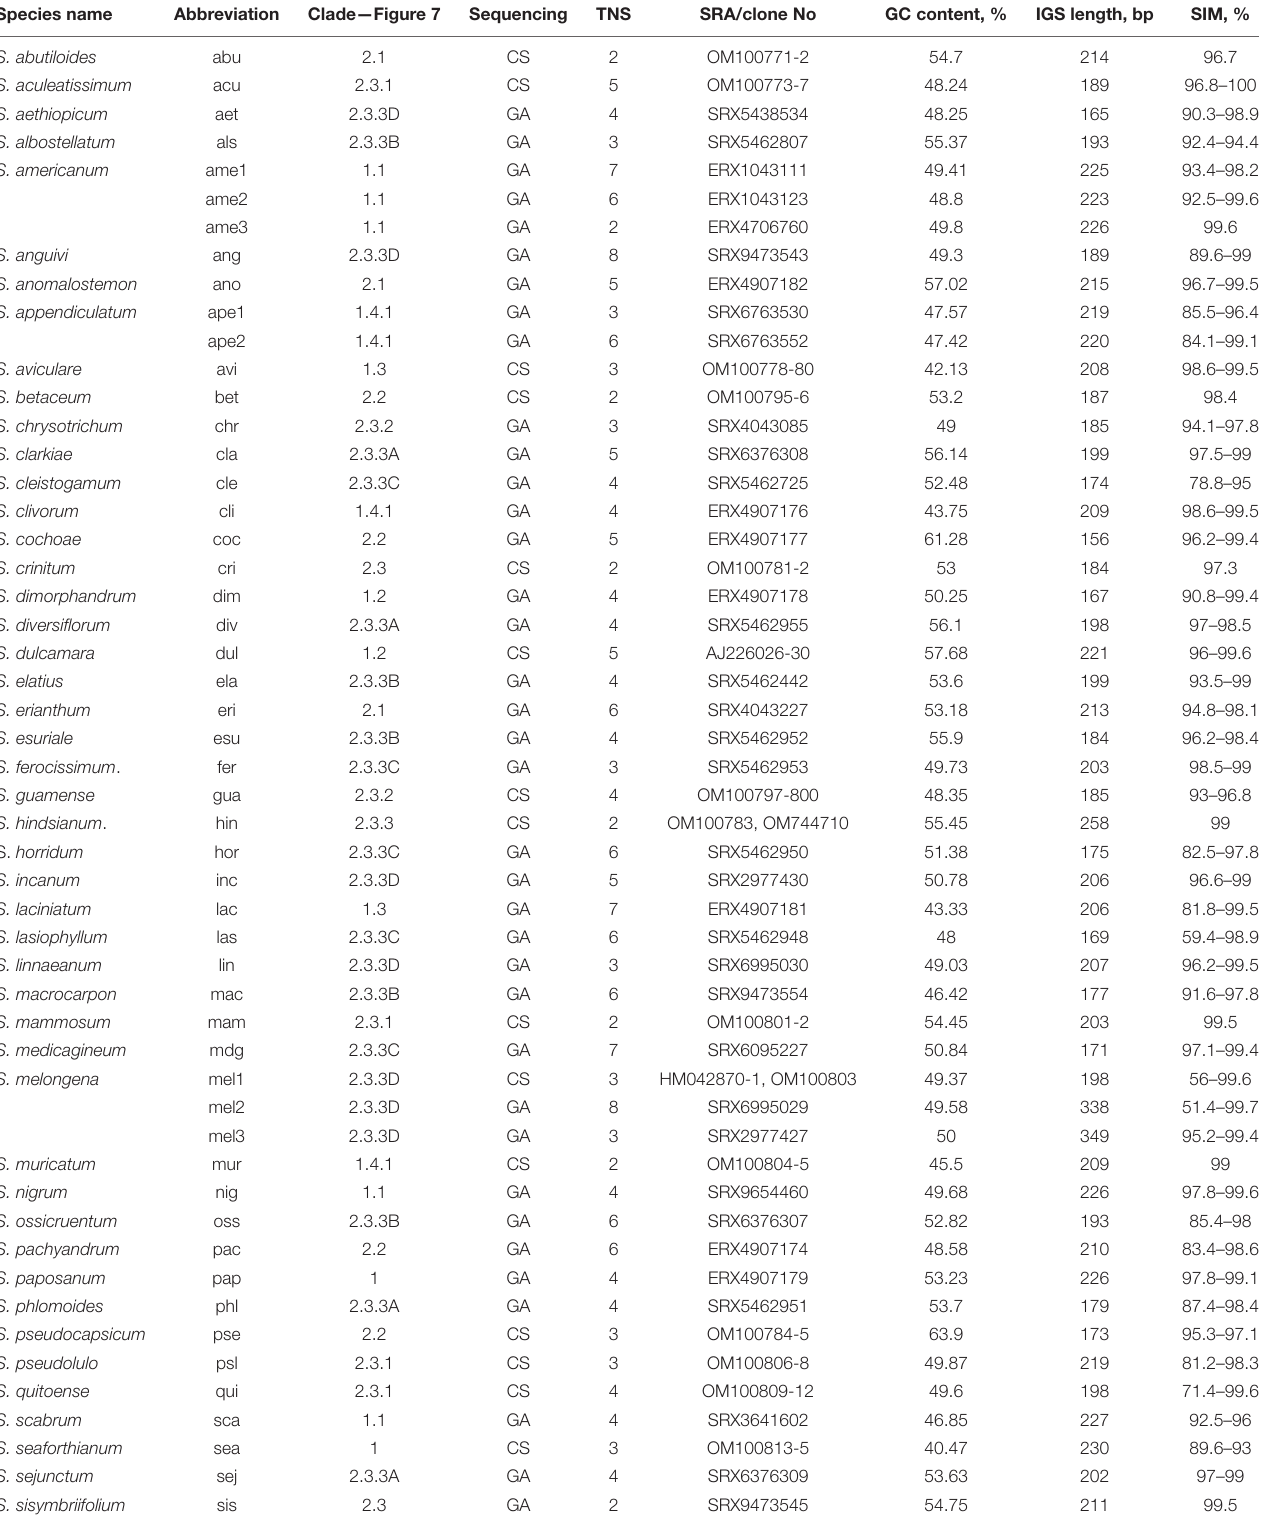
TABLE 3 | Characteristics of the 5S intergenic spacer region (IGS) of Solanum species analyzed (excluding sect. Petota